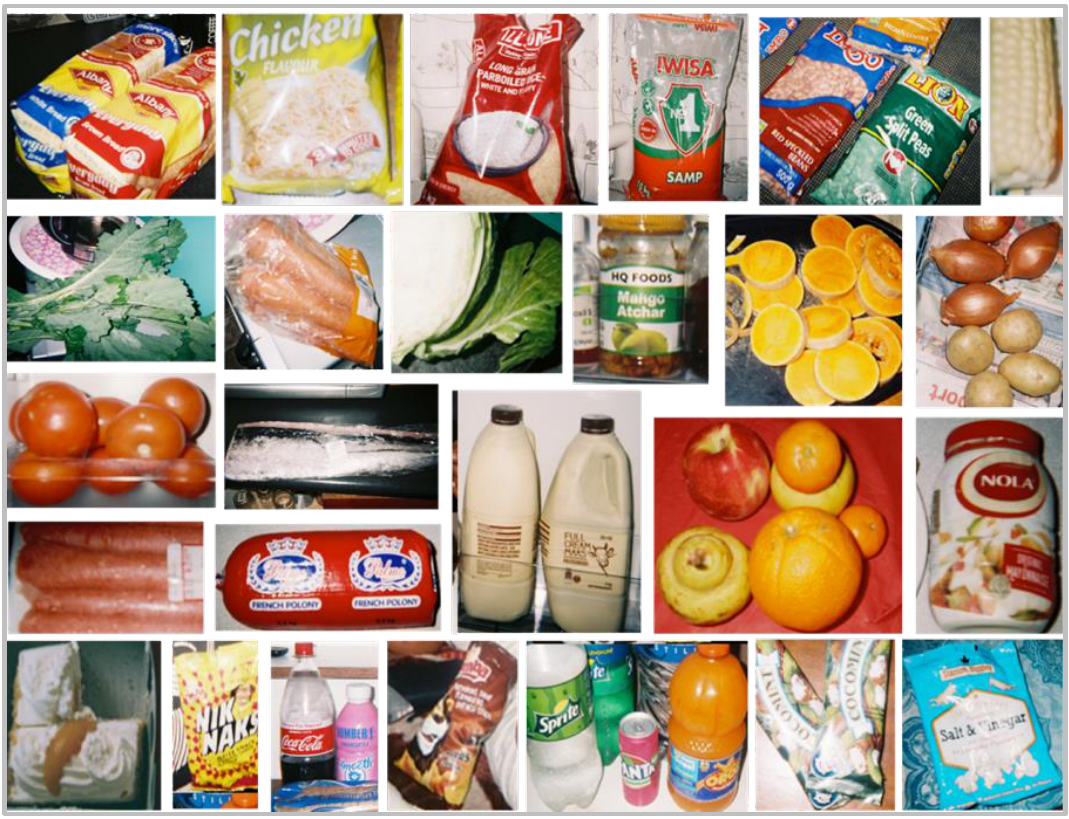
Figure 4. Photographs taken by grade seven learners of foods and snacks available in their homes.